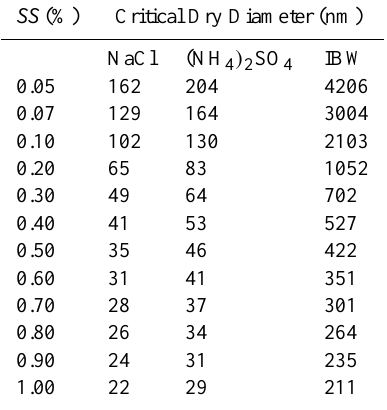
Table 1. Critical Dry Diameter of NaCl, (NH 4 ) 2 SO 4 and an Insol- uble but Wettable (IBW) Particle.